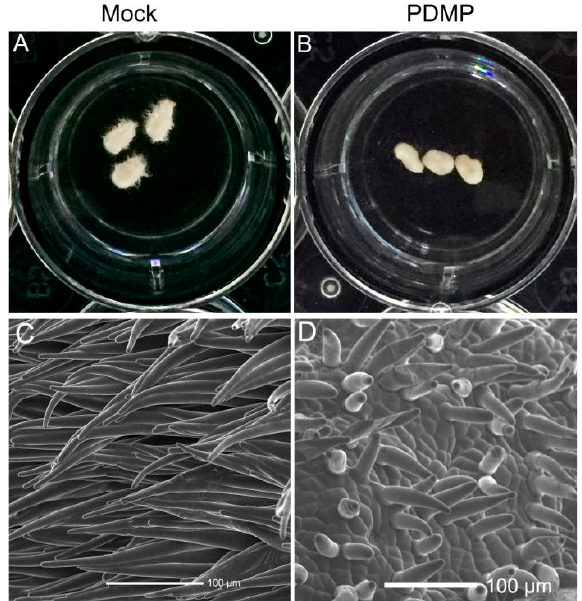
Figure 8. Exogenous application of PDMP in in vitro ovule culture system. ( A ) 0-DPA ovules of XuFL (wild-type) were cultured for five days in the medium adjusted with the amount of DMSO equivalent to that used to dissolve PDMP (Mock). ( B ) 0-DPA ovules of XuFL (wild-type) were cultured for five days in the medium with 60 μ M PDMP. ( C ) The fiber cells on the ovules without treatment. ( D ) The fiber cells on the ovules treated with PDMP. PDMP, 1-phenyl-2-decanoylamino-3-morpholino-1-propanol.